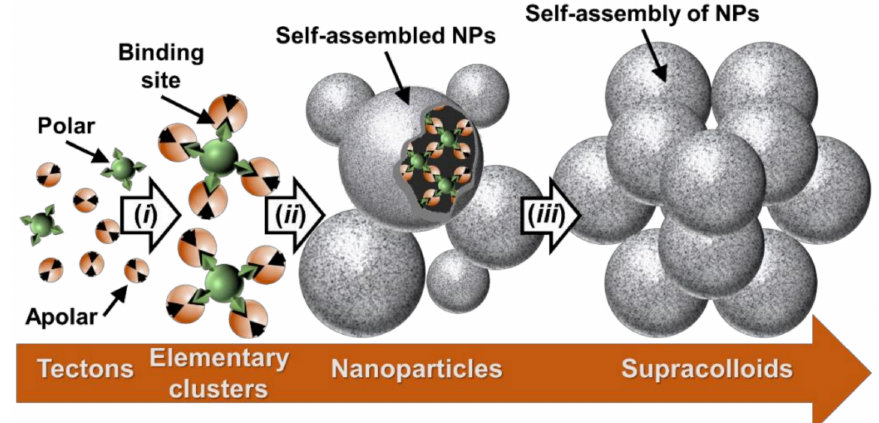
Figure 56. The hierarchical formation of supramolecular colloidal systems based on the “colloidal tectonics” approach: (i) self-assembly between tectons; (ii) nucleation and growth; and (iii) packing of